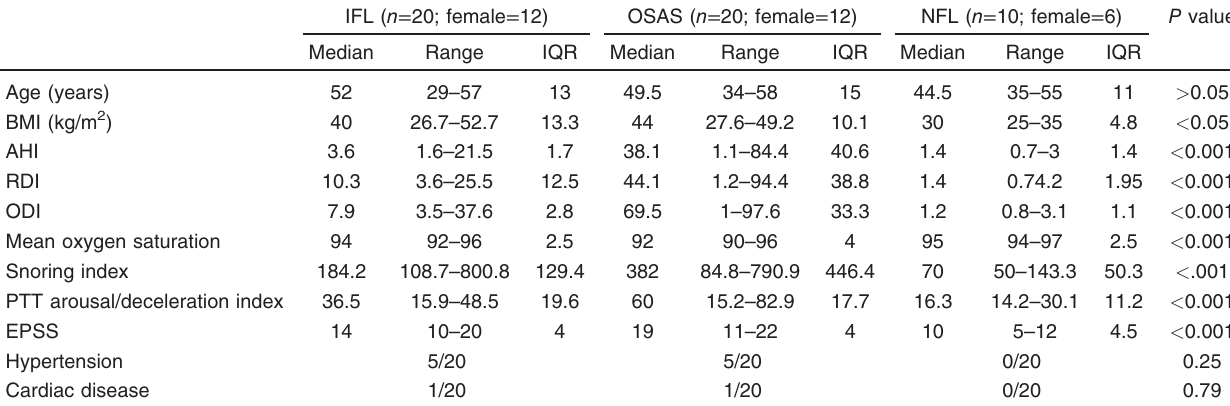
Table 1 Comparison between the studied groups regarding demographic and clinical findings IFL ( n = 20; female = 12)